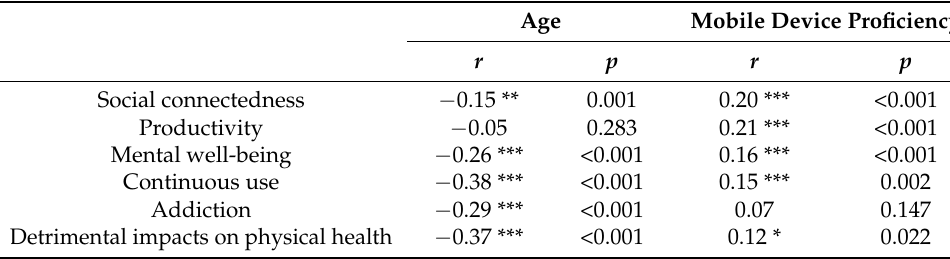
Table 3. Correlations between age and mobile device affinity and usage subscale